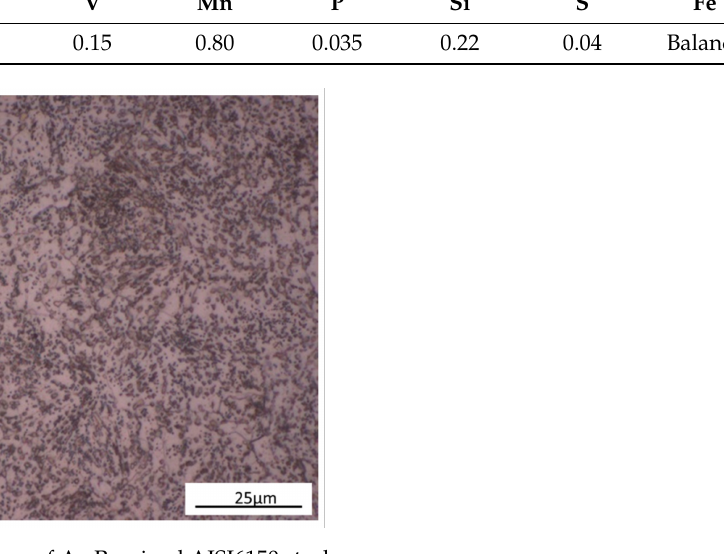
Figure 1. Microstructure of As-Received AISI6150 steel. Table 2. Hardness, HRC, of austempered and quenched-tempered disks after heat-treatment.